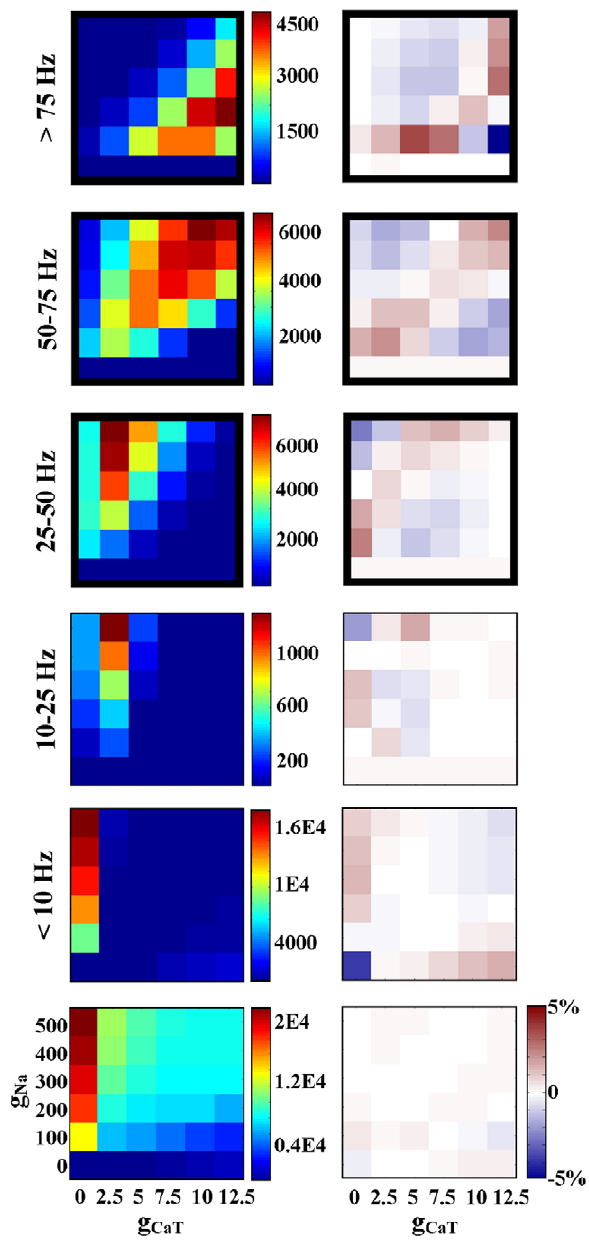
Figure 8. Values of g Na and g CaT are correlated for spiking models with a frequency greater than 25 Hz. Bold black borders indicate a correlation ( x 2 . 500 and | r | . 0.2).